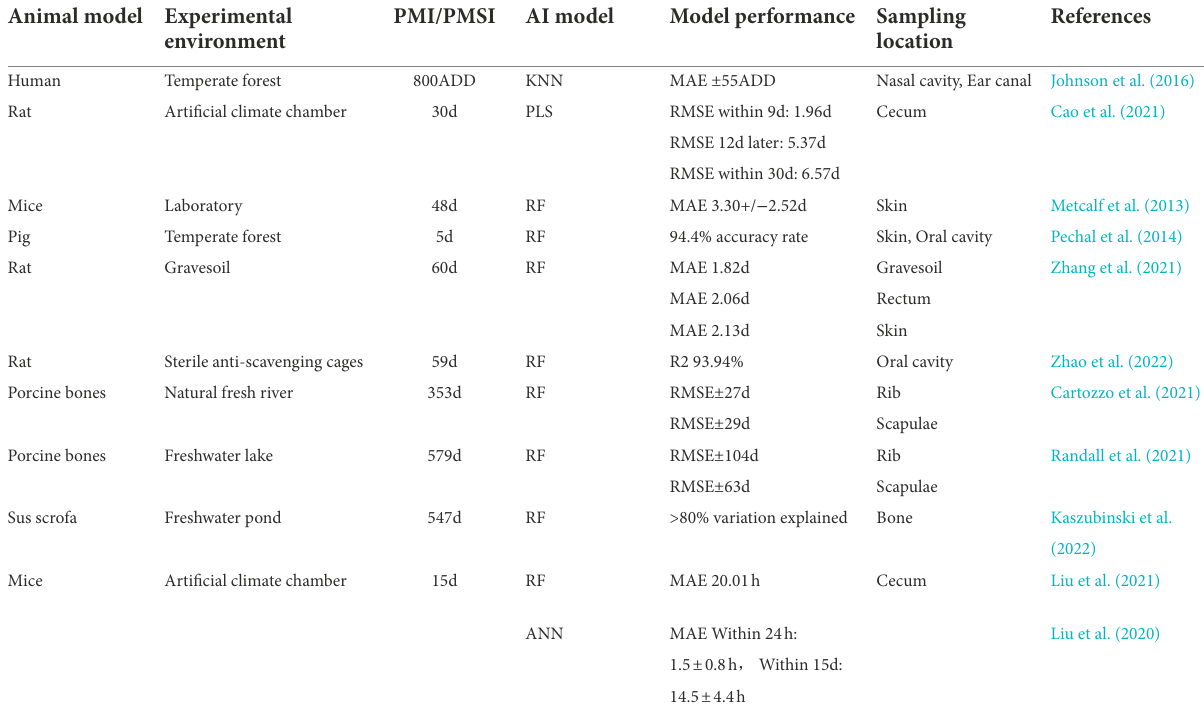
TABLE 1 Application of AI on microbiome for predicting PMI. Animal model Experimental